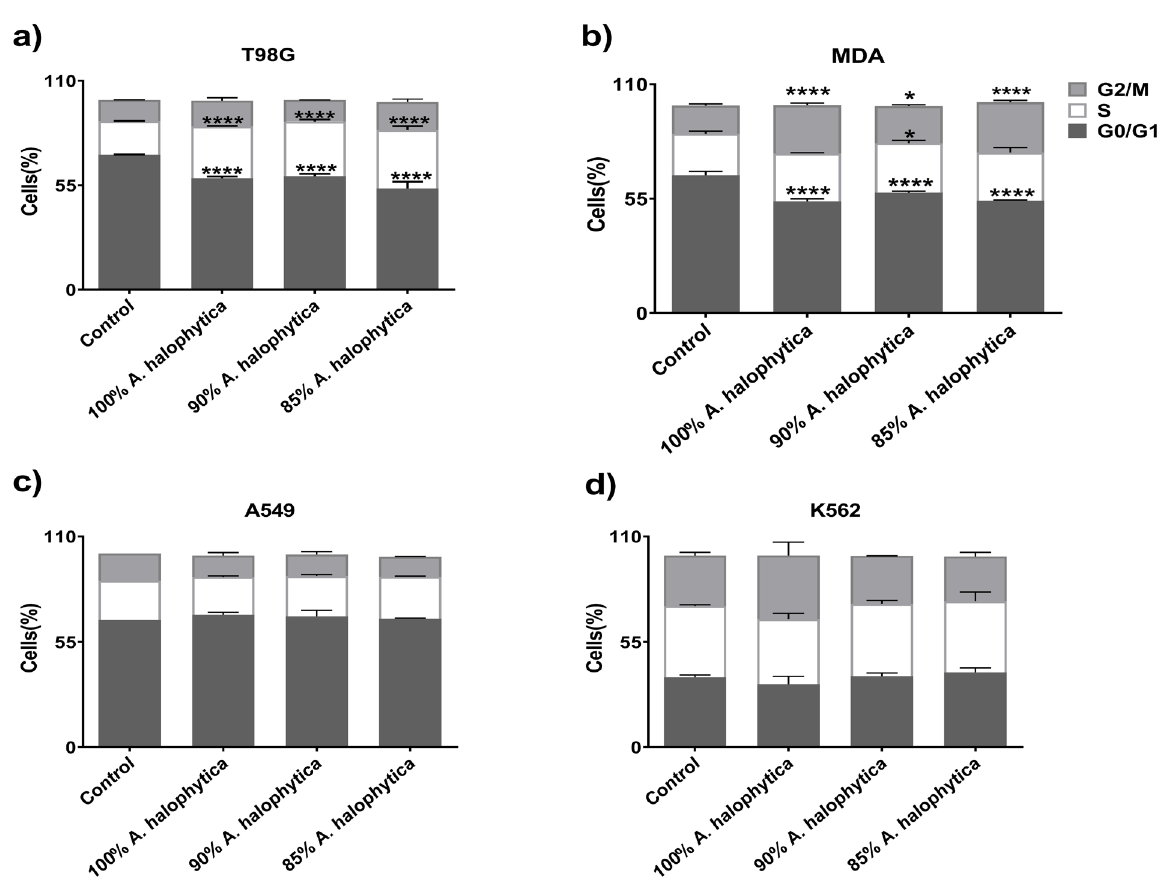
Figure 3. Aphanothece halophytica extracts induced cell cycle arrest. T98G (a), MDA231(b), A549(c) and K562(d) cells cultured with cyanobacterial extracts after 72 hours with their highest concentration [1000µg/mL]. Representative result of flow cytometry experiment considering a minimum of 10,000 events, being the mean ± standard deviation. Two-way ANOVA with Dunnett‘s post-test relative to control; * P <0.05, **** P